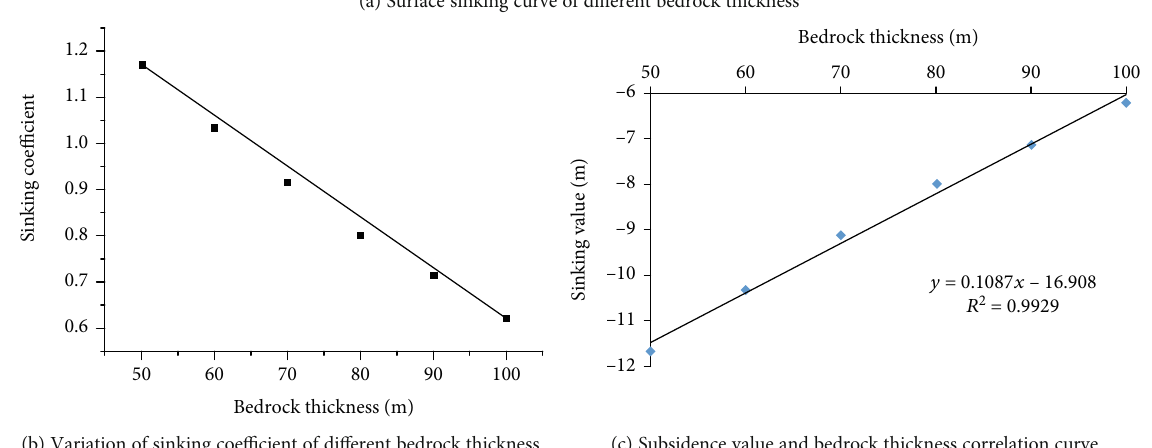
Figure 14: Di ff erent bedrock thickness a ff ects